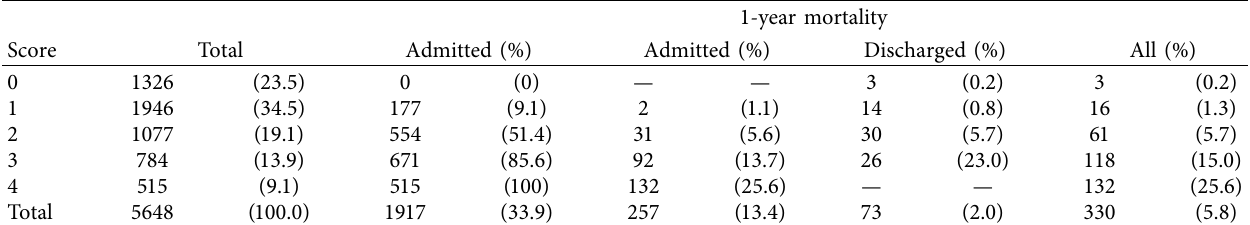
Table 3: 1-year mortality according to the SPS and admission. 1-year mortality according to the SPS and hospital admission, also showing the total number of mortality per score